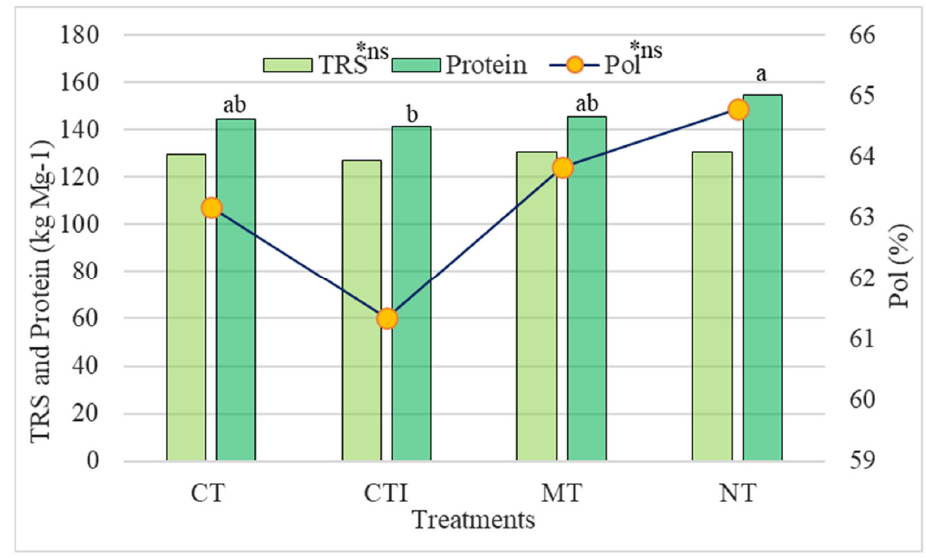
Figure 6. Sugarcane broth chemical evaluation (fresh matter) of total reducing sugars (TRS), crude protein (Protein), and apparent sucrose content (Pol) as a function of treatments: NT; MT; CT, and CTI. Means followed by the same letter do not differ by Tukey's test, at 5% significance. *ns indicates no difference between means.